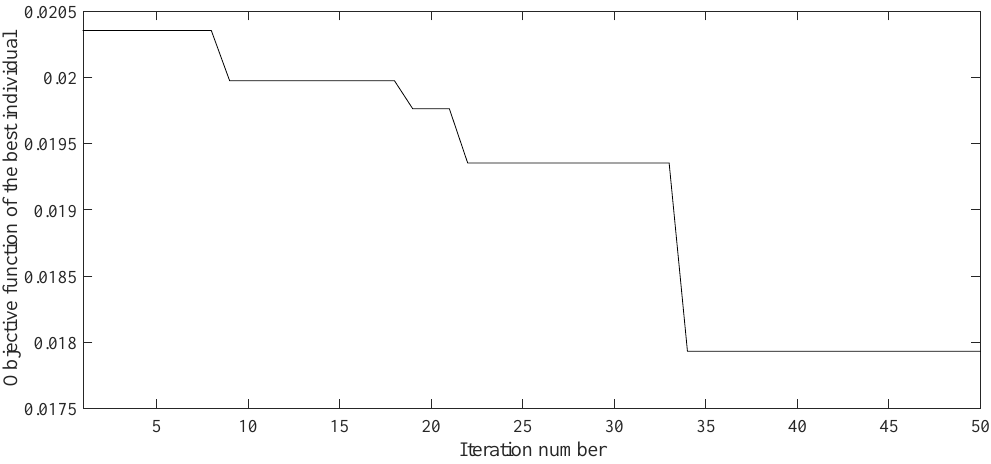
Figure 8. Selection of the stopping criterion for the Genetic Algorithm